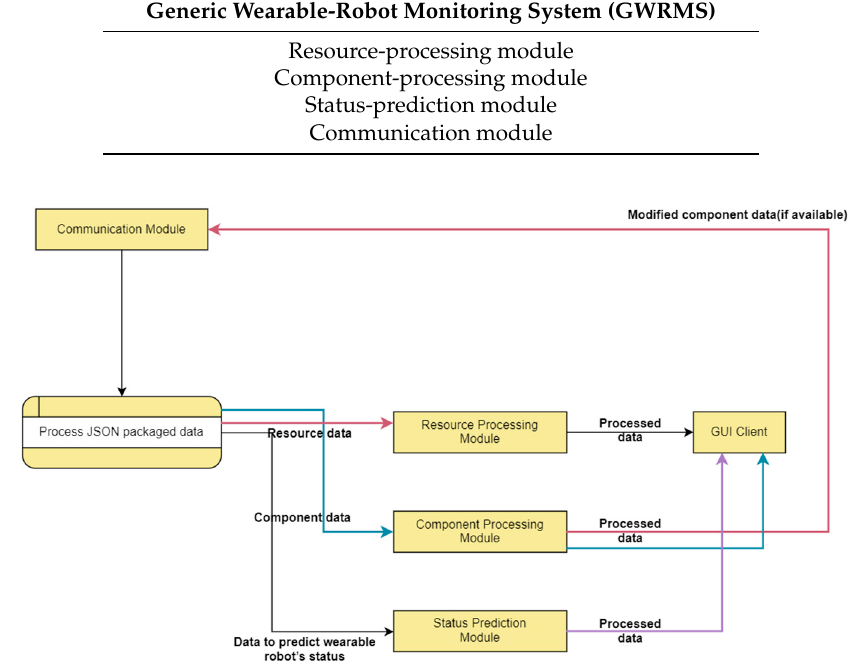
Figure 3. Data flow diagram showing the interactions between server components.